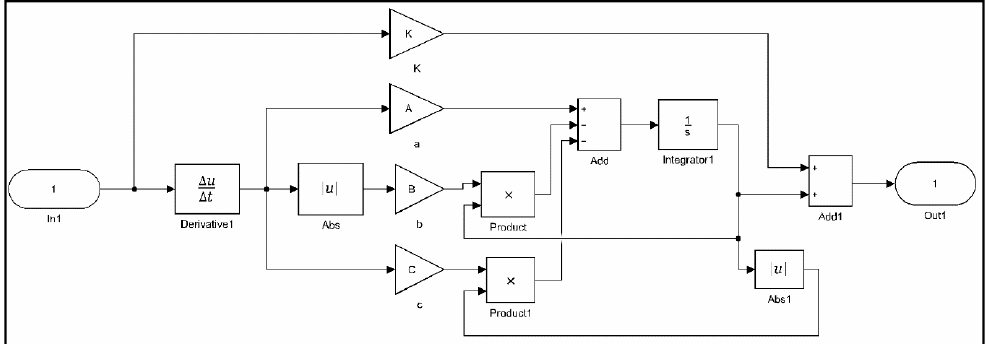
Figure 5. Classical Bouc–Wen (CB–W) model implemented with Matlab/Simulink.